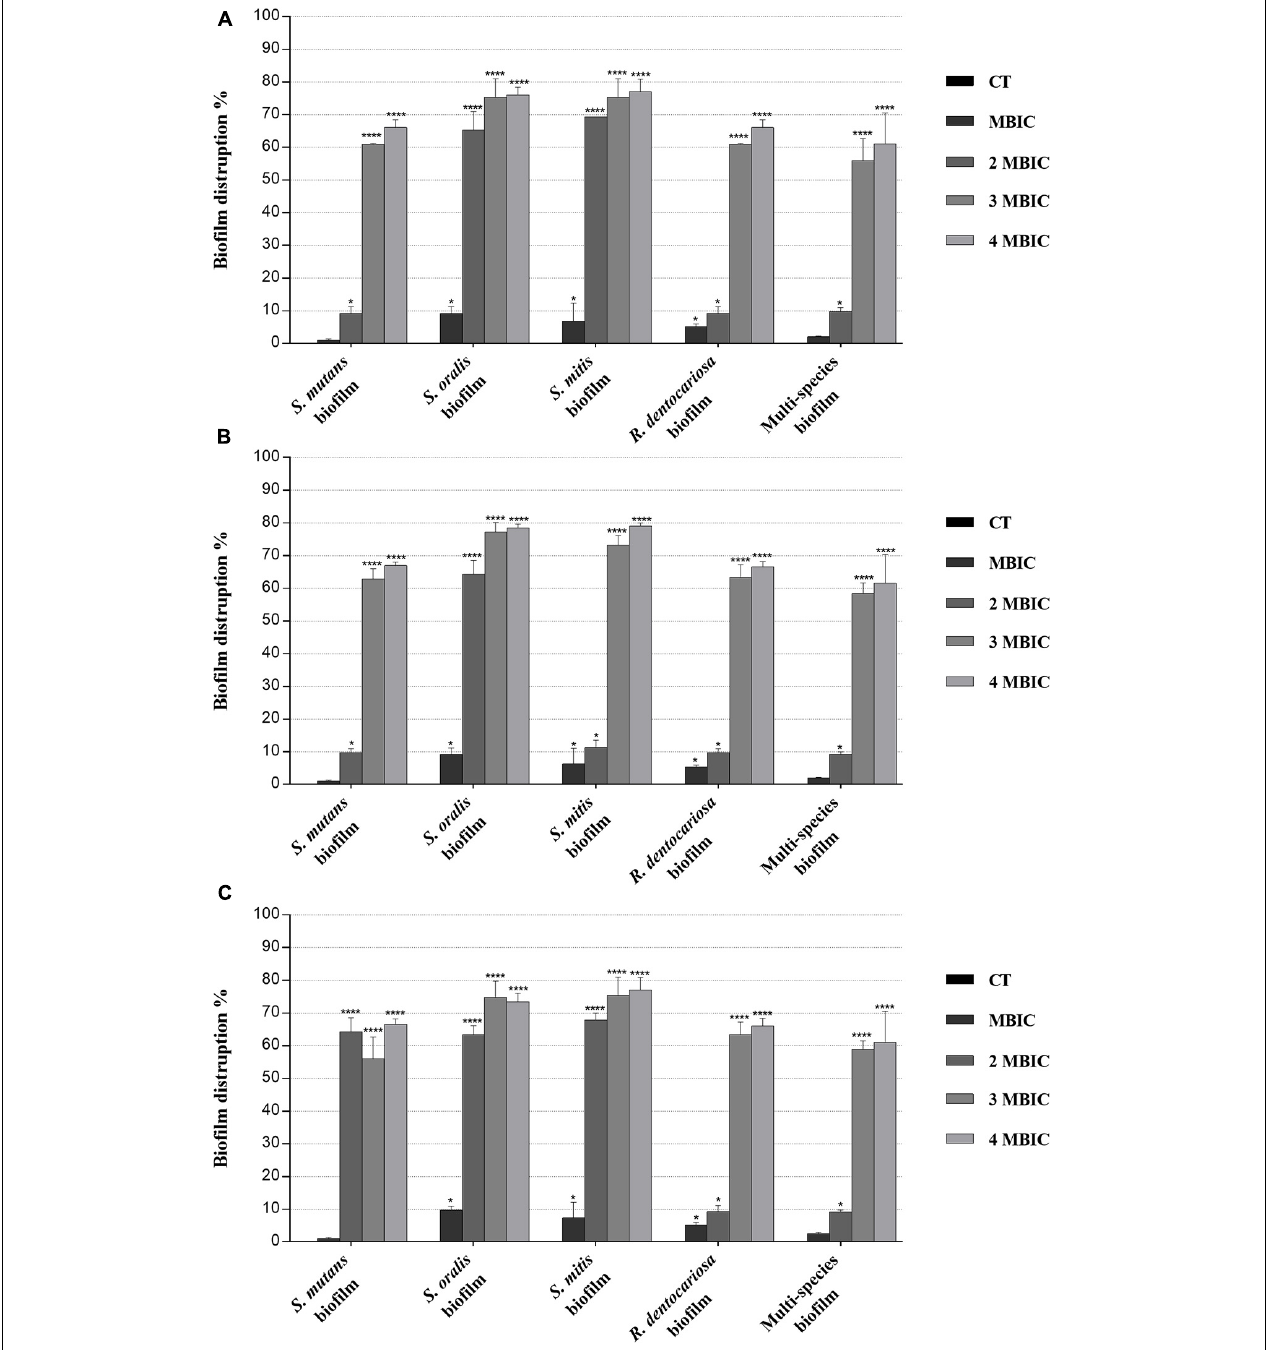
FIGURE 3 | Biofilm eradication activity of myrtle and pomegranate polyphenolic extracts, also in binary combination, on single - species and multispecies mature biofilms of S. mutans ATCC 25175, S. oralis SO1, S. mitis SM2, and R. dentocariosa RD1 oral isolates. Figure shows the disruption percentage values of S. mutans ATCC 25175, S. oralis SO1, S. mitis SM2, and R. dentocariosa RD1 oral isolates in single and multispecies biofilms (1:1:1:1 ratio for each isolate) detected in the presence of MBIC and over-MBIC (2 MBIC, 3 MBIC, and 4 MBIC) concentrations of myrtle leaf 50% hydroethanolic extract (MLE) (A) ; pomegranate peel 50% hydroethanolic extract (PPE) (B) ; myrtle leaf 50% hydroethanolic extract in combination with pomegranate peel 50% hydroethanolic extract (MLE + PPE) added in a 1:1 ratio (C) . The experiments were performed in triplicate with independent cultures, and statistical significance was examined by the two-way ANOVA test with Dunnett correction. Results are indicated as means ± SDs. Asterisks indicate statistical significance (* p < 0.05; **** p < 0.0001).